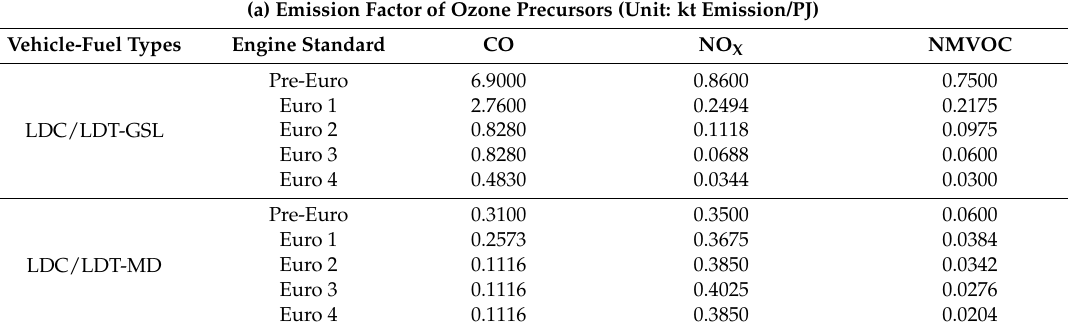
Table A1. Emission factor used in this